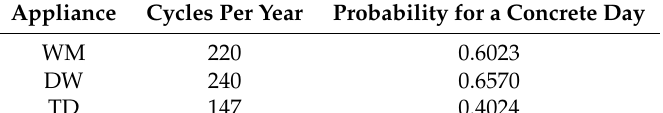
Table 1. The average number of cycles for specific DE appliances.